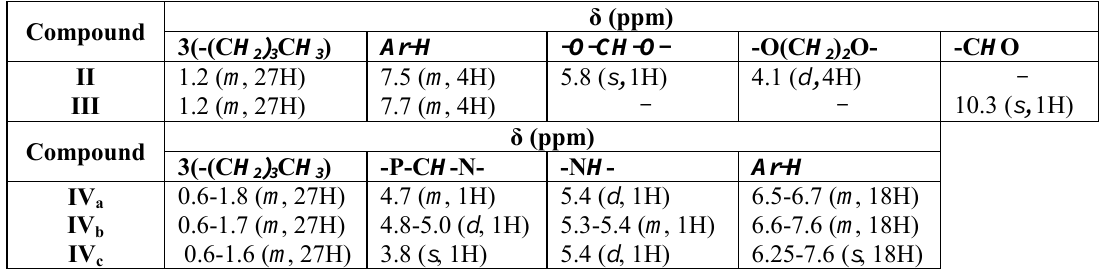
Table 5. 1 H-NMR data of the titled compounds.